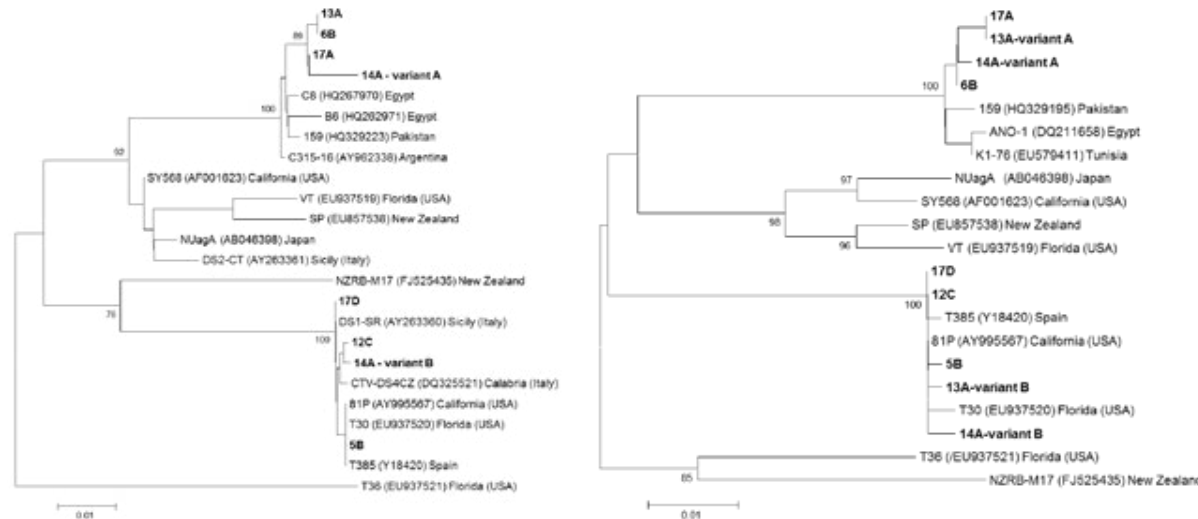
Figure 2. Phylogenetic trees generated by the neighbour-joining method from the alignment of the nucleotide sequences of the genes p20 (left) and p25 (right) of selected CTV isolates using MEGA (Version 5). Bootstrap values (percentage) for 1000 rep- licates are indicated at the main branches. Branch lengths are proportional to number of nucleotide changes. The sequences in bold were obtained in the present study. GenBank accession numbers for the Calabrian isolates are reported in the Table